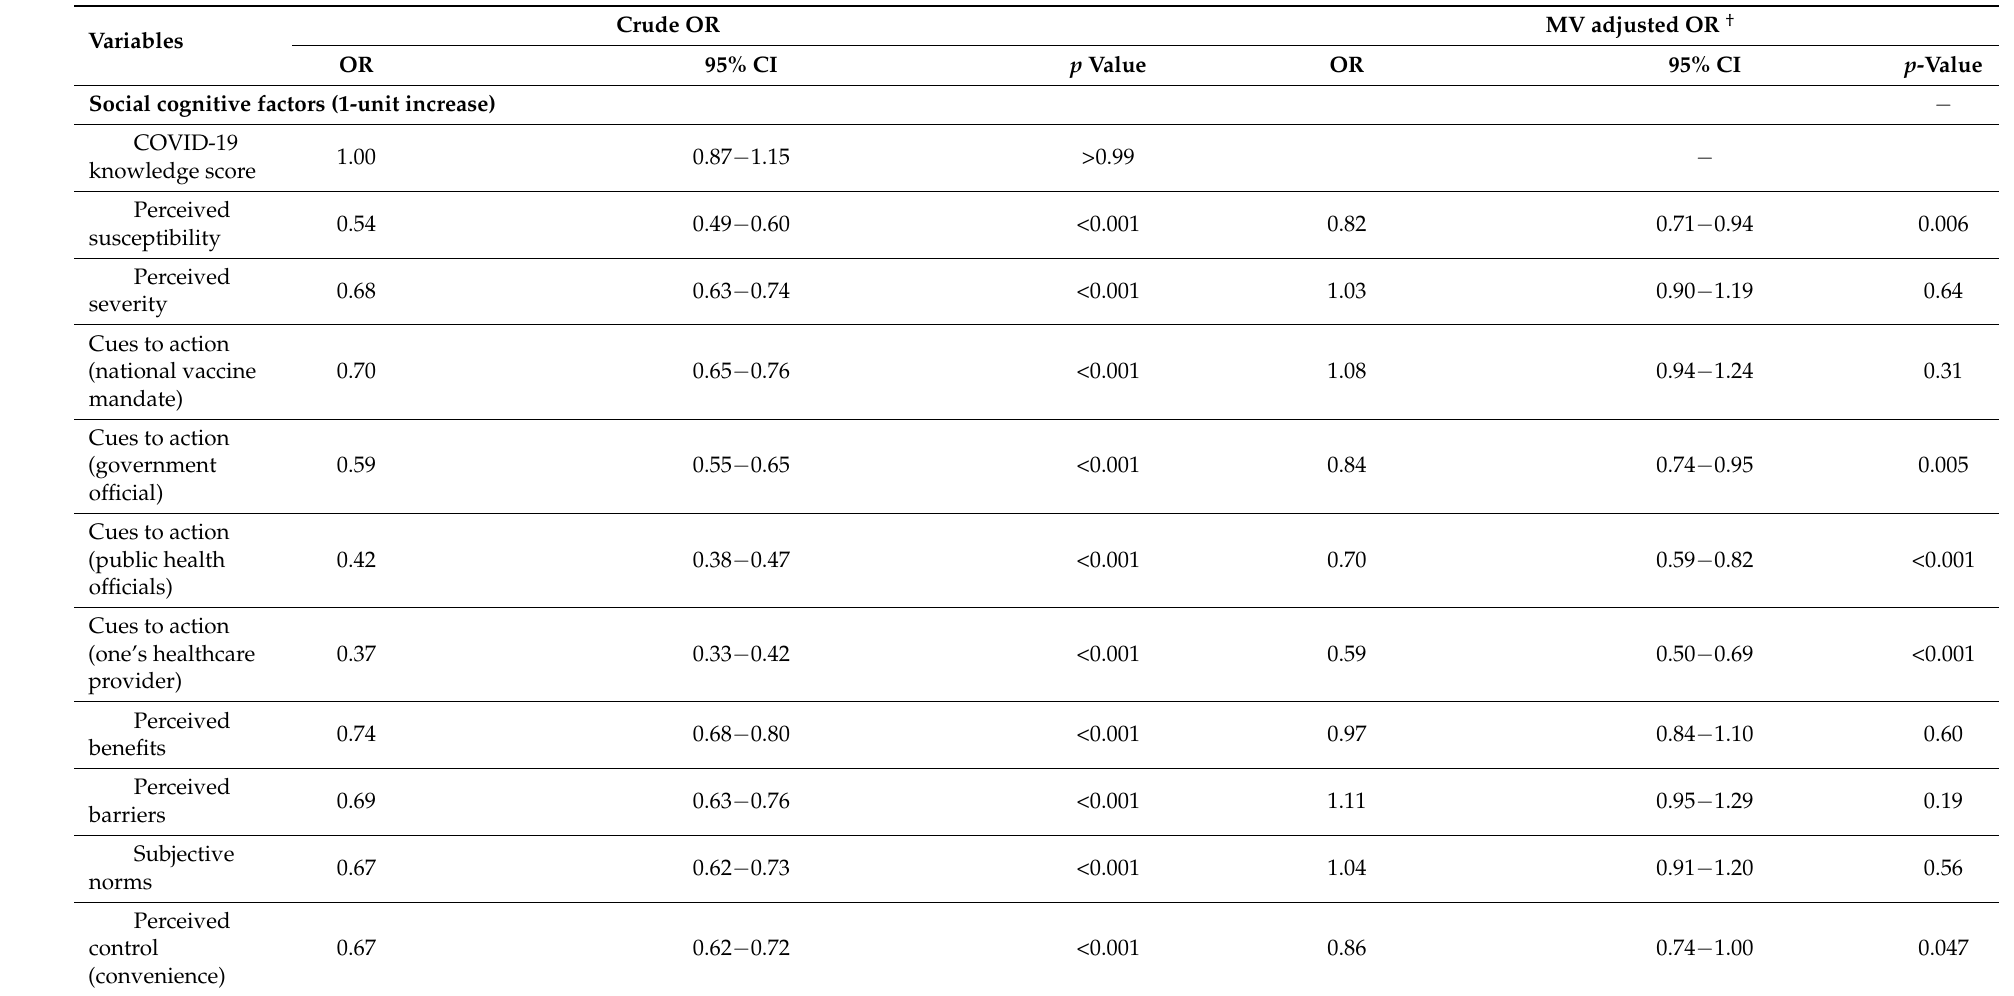
Table 2. Univariate and multivariable analysis for vaccine hesitancy